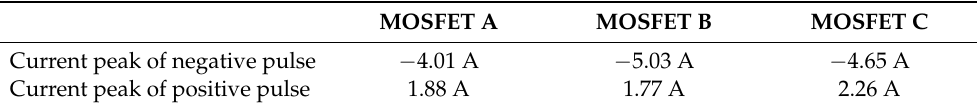
Table 2. Peak values of the discharge current during the falling and rising phases for different SiC-MOSFETs.